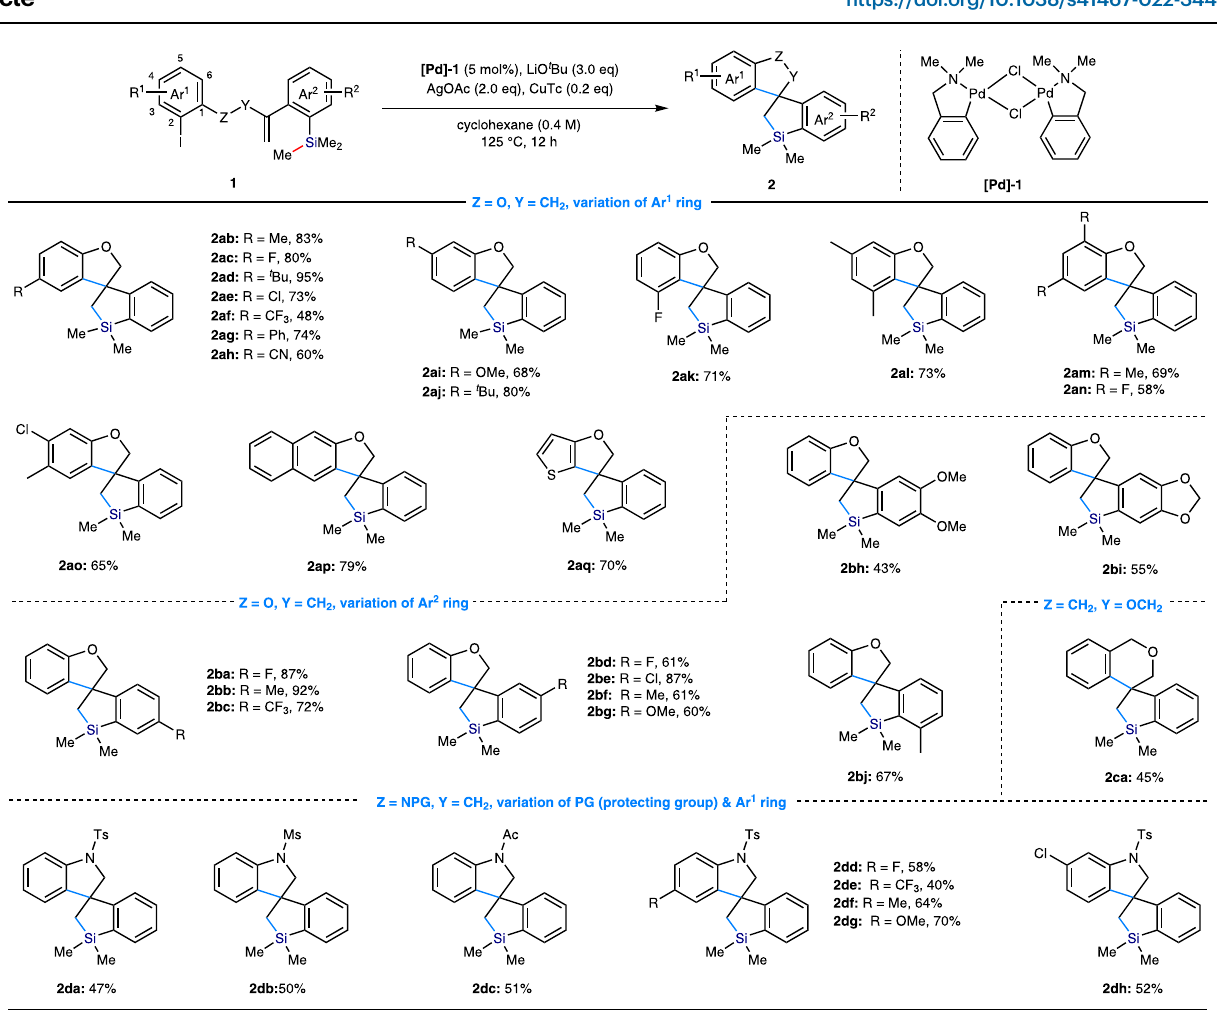
(0.2mmol) in Cyclohexane (0.4M) or Toluene (0.4M) for 4 – 12h. Isolated yields are shown.